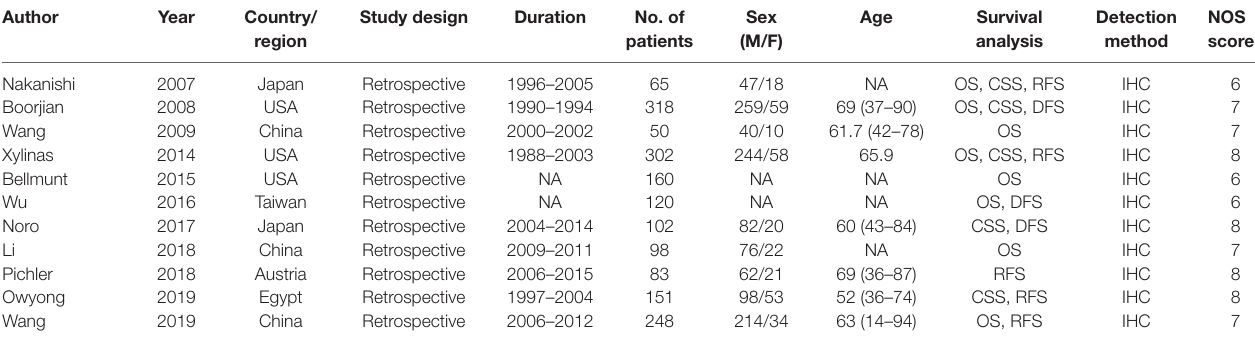
TABLE 1 | Basic characteristics of included